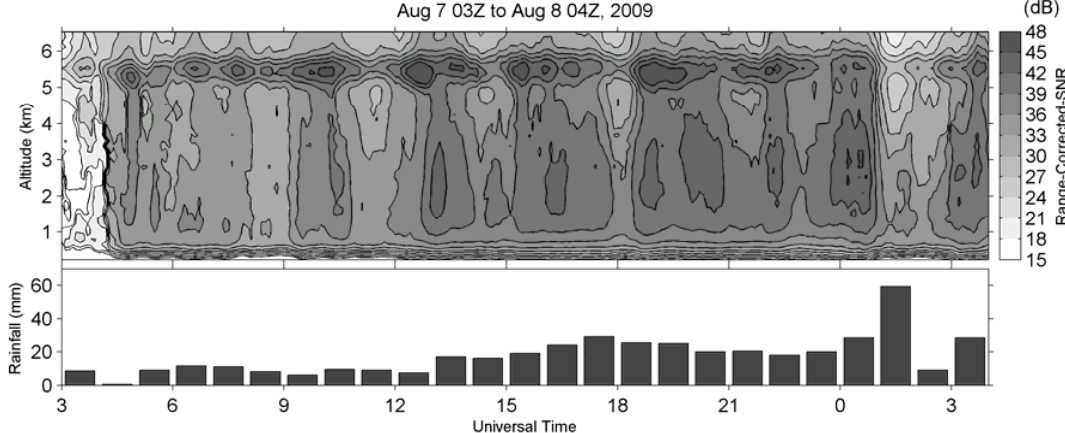
Fig. 1. Observation during the passage of Typhoon Morakot during 7–8 August 2009. (a) Time-height Cross section of range-corrected Signal-to-Noise ratio (dB) and (b) hourly rainfall accumulation at Zuoying. Meteorological Station, distance of about 60 km and 20 km, respectively. More